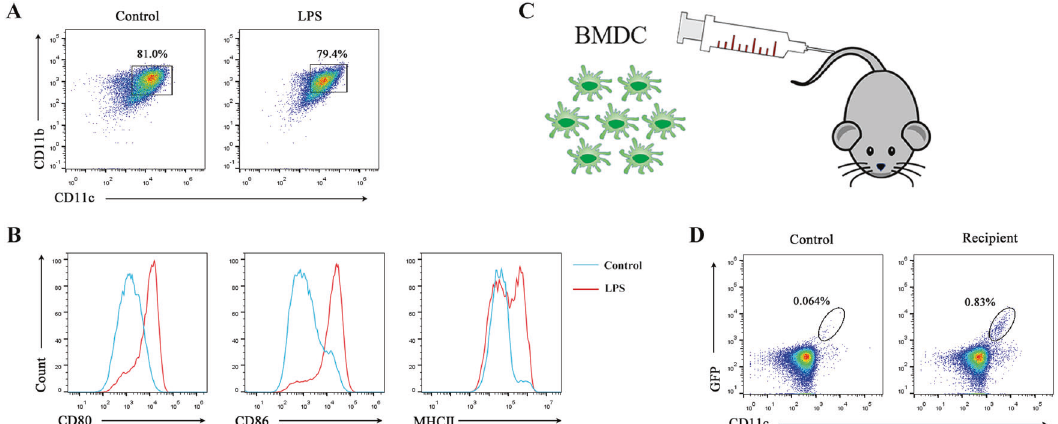
Fig. 1 Mature DCs could return to the thymus. A Bone marrow cells were isolated and cultured with GM-CSF (10 ng/ml) plus IL-4 (1 ng/ml) for 7 days. On day 7, imBMDCs were harvested and incubated with LPS (1 μ g/ml). Subsequently, the cells were collected and stained with anti- CD11c and anti-CD11b antibodies. The expressions of CD11c and CD11b in BMDCs were assessed by FCM. B BMDCs were stained with anti- CD11c, anti-CD11b, anti-CD80, anti-CD86, and anti-MHC II antibodies. The expressions of CD80, CD86, and MHC II in CD11c + CD11b + cells were veri fi ed by FCM. C The carton showed that GFP + mBMDCs (1.0 × 10 7 ) were injected into wild-type mice via the caudal vein. D CD11c + GFP + cells from the thymus of recipients were analyzed by FCM. All data are from three independent experiments. Representative fi gures of these three experiments are